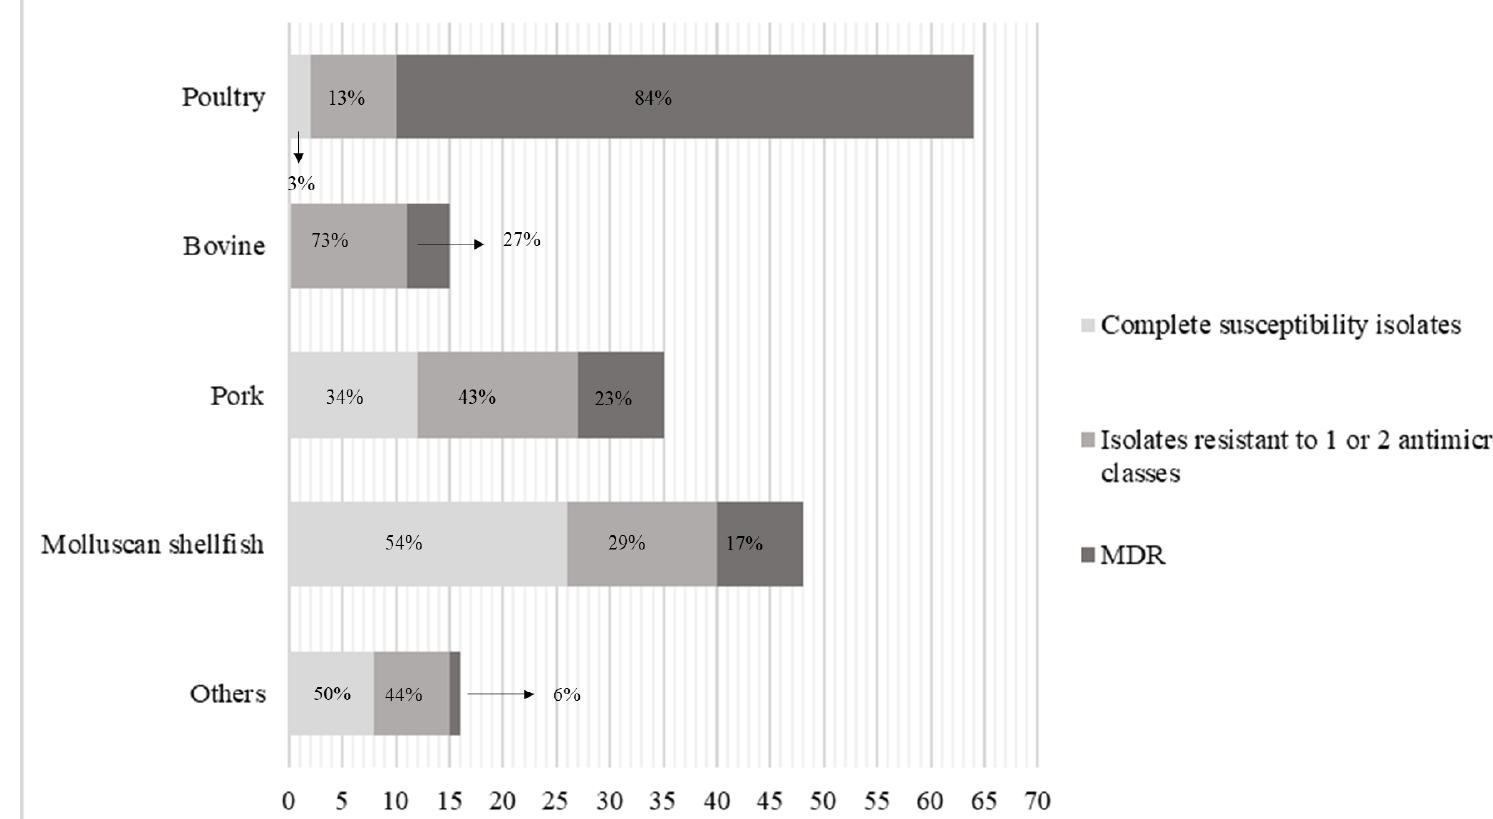
Figure 4. Number and percentage of completely susceptible Salmonella isolates, isolates resistant to one or two antimicrobial classes, and multidrug resistant (MDR) isolates from poultry, bovine, pork, and molluscan shellfish. Isolates from buffalo, ovine, snail, vegetables, and mixed meat products were summed and are denoted as “ Others ” .